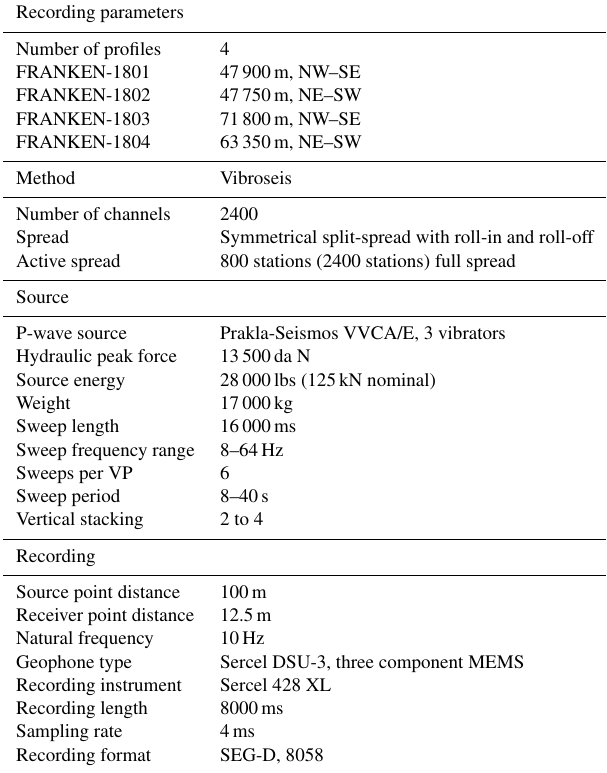
Table 2. Recording parameters of the FRANKEN seismic